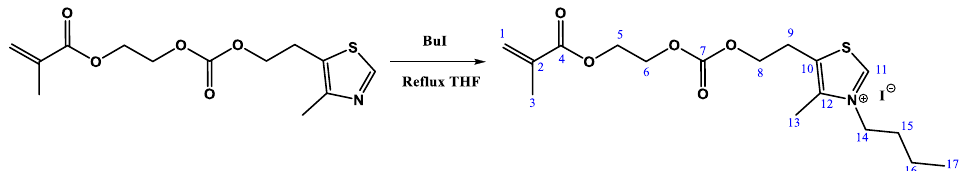
Scheme 3. N -alkylation reaction of 2-(((2-(4-methylthiazol-5-yl)ethoxy)carbonyl)oxy)ethyl methac- rylate. Synthesis of